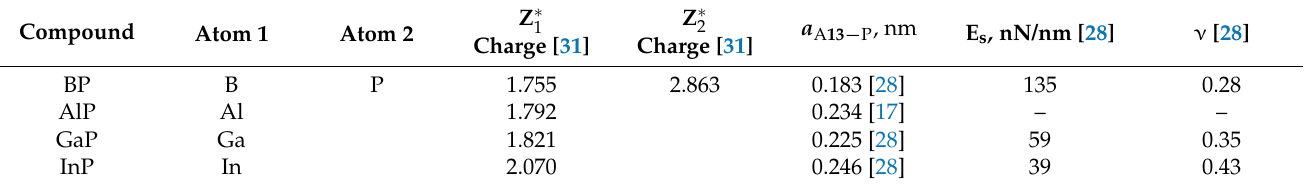
Table 2. Effective charges of atoms [31], and bond length, surface Young’s modulus and Poisson’s ratio, obtained from DFT computations [28], for phosphide